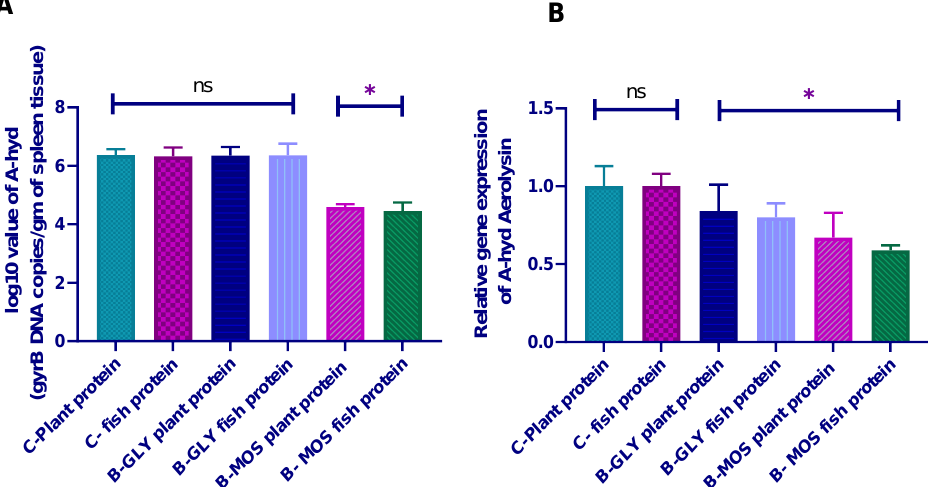
Figure 4. Effect of dietary protein source and carbon source on ( A ): Aeromonas hydrophila gry-B gene measured by quantitative real time PCR results (log 10 copies / gm spleen tissue), *( B ): Aeromonas hydrophila Aerolysin virulence gene expression (data are expressed as mean ± SEM). * Bars with an asterisk correspond to values that are significantly different (Tukey, p < 0.05) ns bars, with ns corresponding to values that are not significantly different.